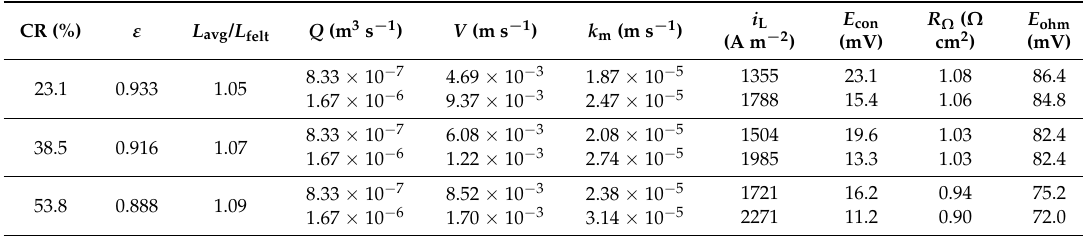
Table 1. Impact of varying CRs on VRFB properties at an operating current density of 80 mA cm − 2 and SOC of